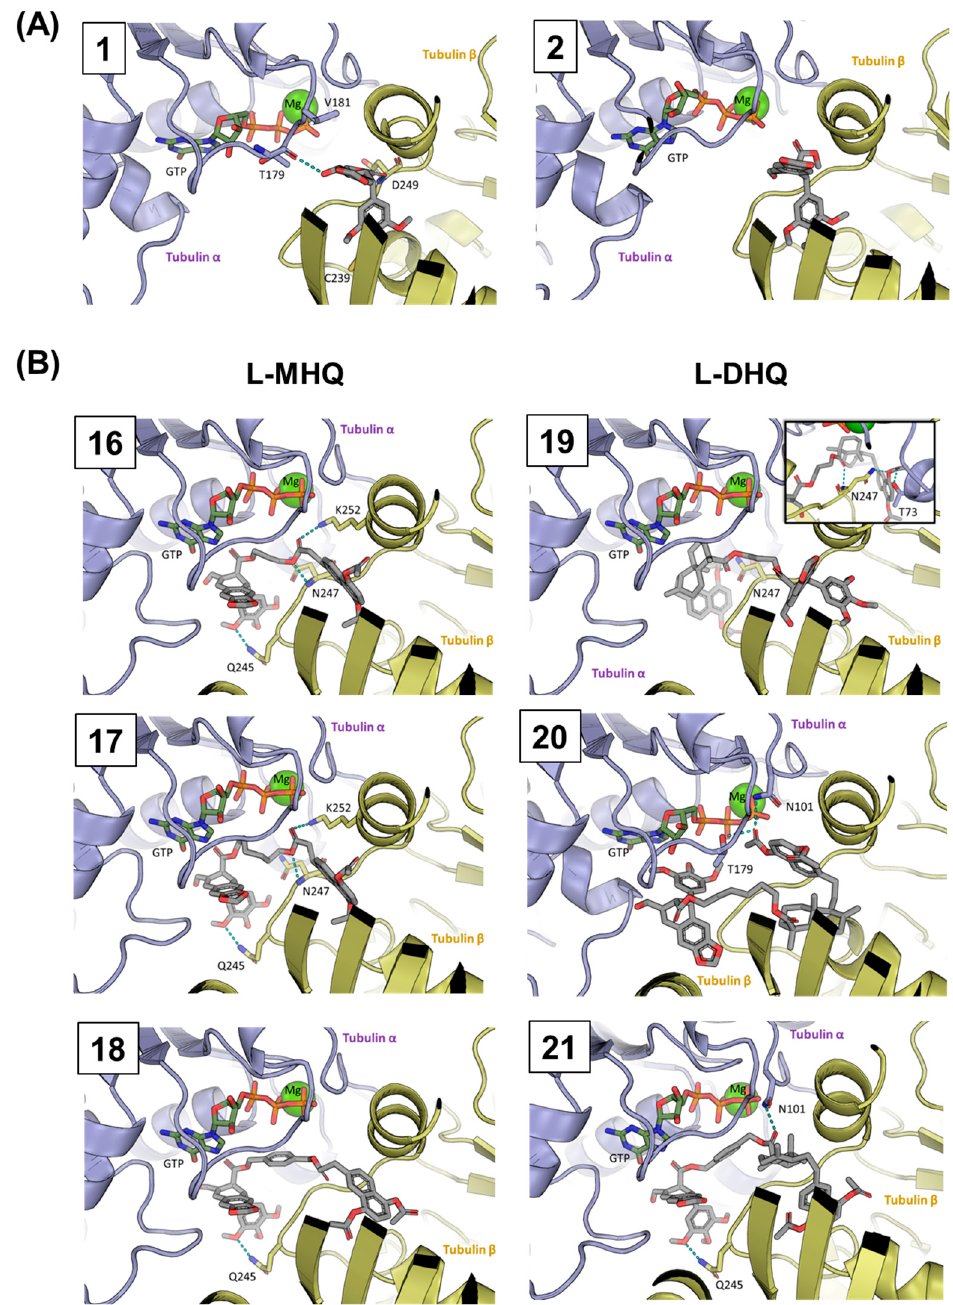
Figure 8. Docking complexes in the colchicine binding site of tubulin for: ( A ) precursors 1 and 2 and ( B ) L-MHQs 16 – 18 and L-DHQs 19 – 21 . GTP, the inhibitors, and those residues that interact with the inhibitors via hydrogen bonds are shown atomistically. The two protomers α - and β -tubulin are shown in purple and yellow, respectively.